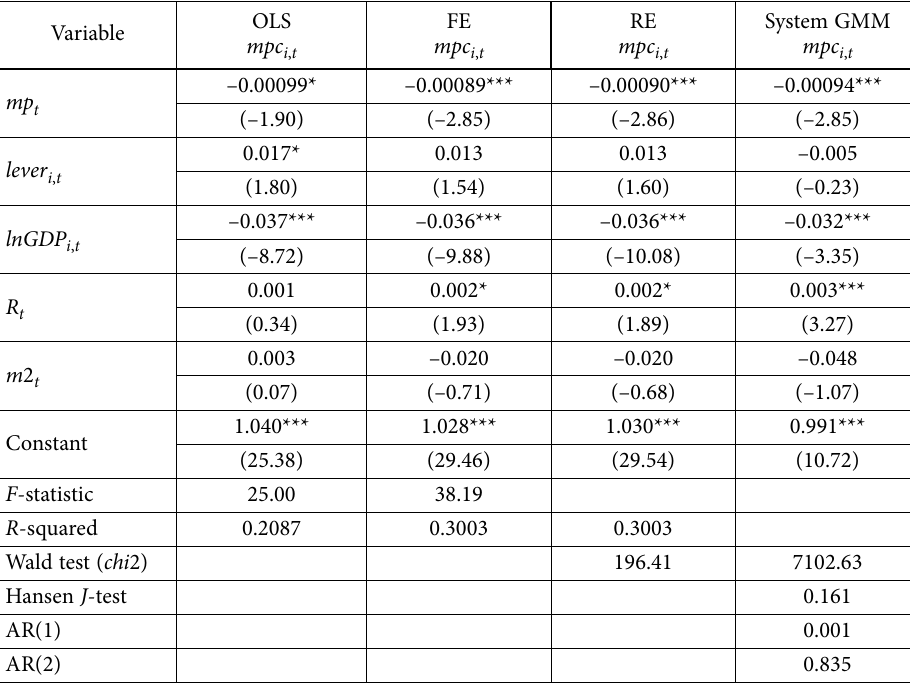
Table 8. The impact of macroprudential policies on consumption through credit